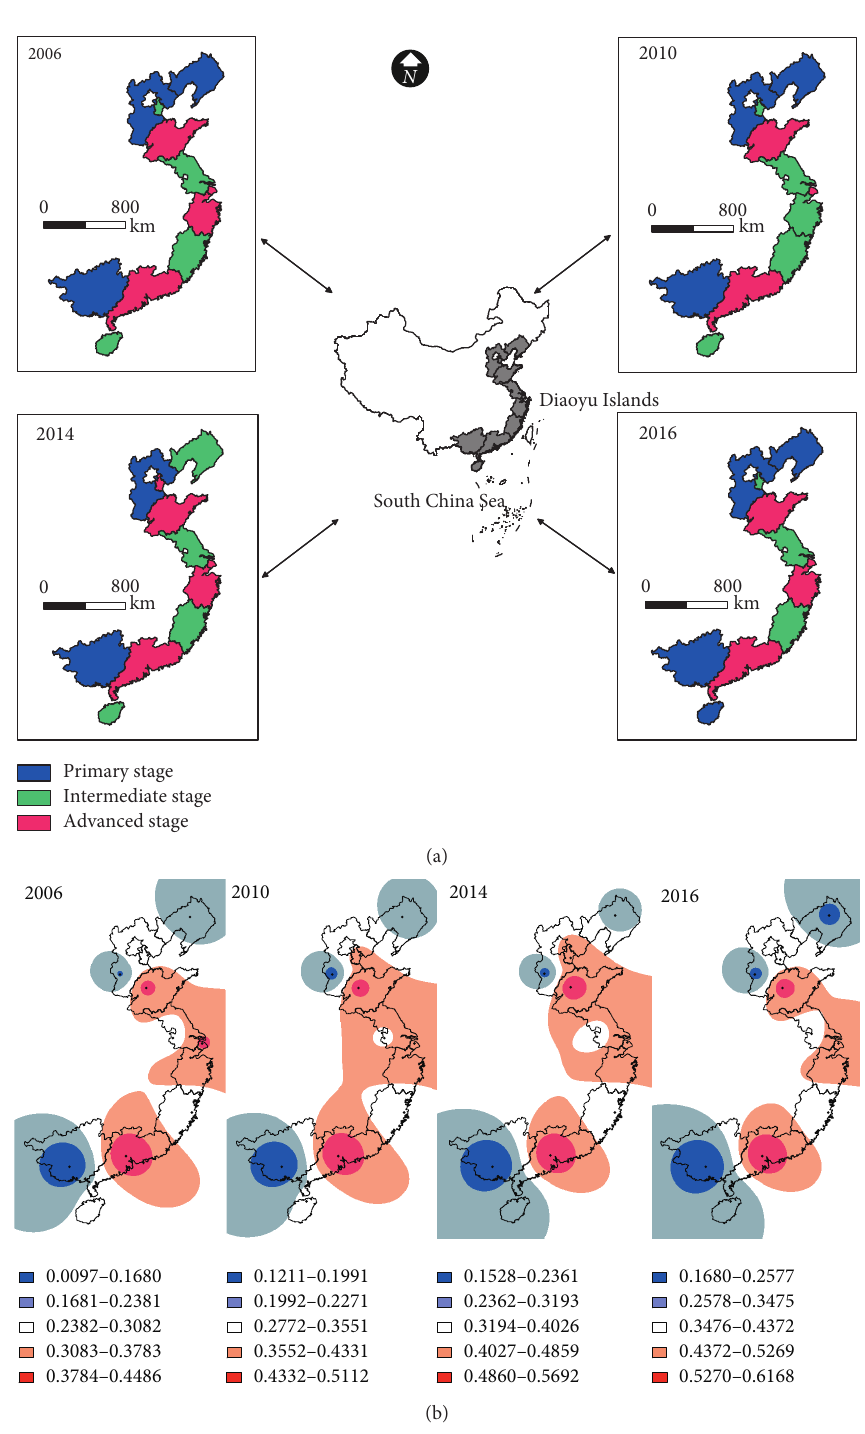
Figure 4: Spatial features of the high-quality development of China’s marine